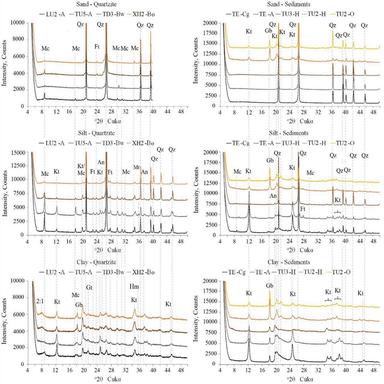
X-ray diffractogram of the sand, silt, and clay fractions of Lithic Ustorthent (LU2), Typic Ustorthent (TU5), Typic Dystrustept (TD3) and Xanthic Haplustox (XH2) derived from quartzite; Typic Endoaquent (TE) derived from mineral sediments; Typic Udifolist (TU2) and Typic Ustifolist (TU3) derived from organic sediments in Brazil. Kt – Kaolinite; Mc – muscovite; Gb − gibbsite; Ft − feldspar; An − anatase; 2:1–2:1 minerals; Qz − quartz.